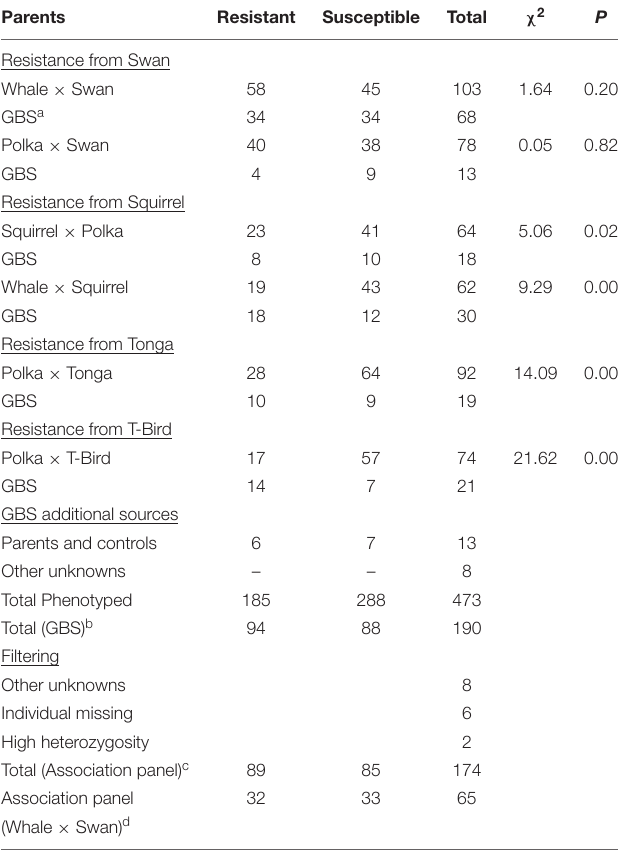
TABLE 1 | Spinach progeny populationsegregating for downy mildew response following inoculation with race 13 of P. effusa. Parents Resistant Susceptible